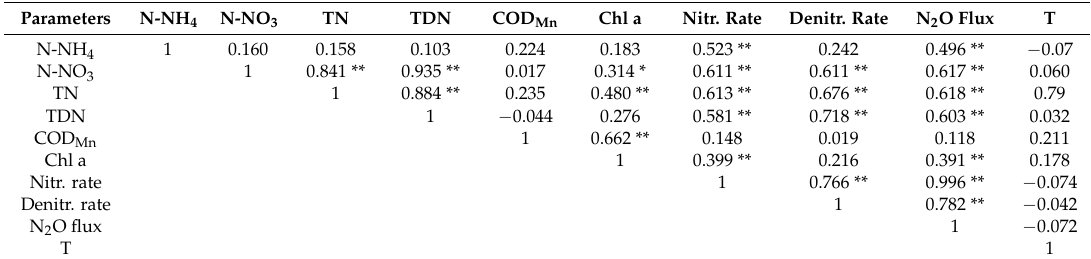
Table 3. Correlations among N 2 O flux, nitrification rate, denitrification rate, and water parameters.